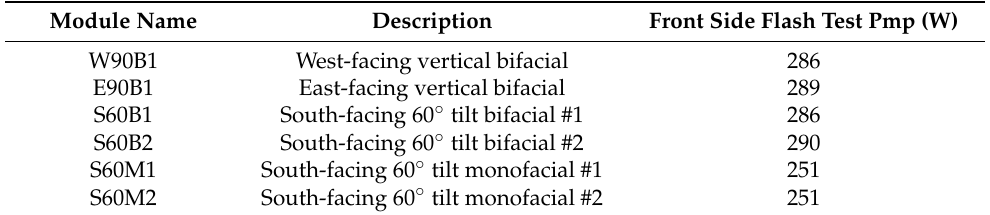
Table 2. Flash test results for the front side maximum power output (Pmp) at standard test conditions for the PV modules included in this